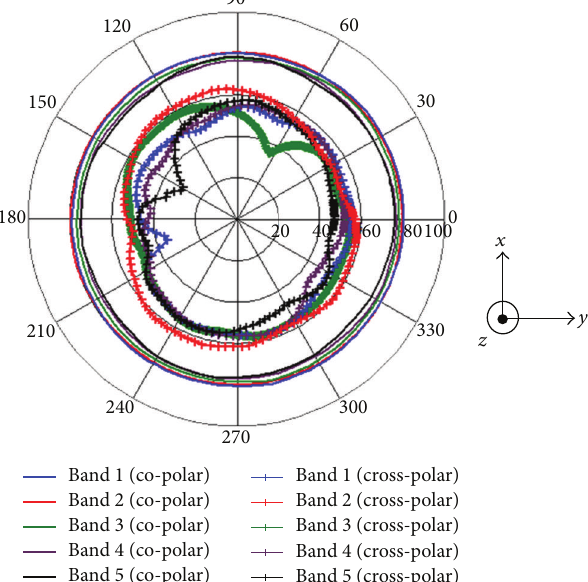
Figure 7: Measured H-plane radiation patterns (co-polar & cross- polar) at operating frequency, 𝑓 , for TMFDB25 with stubs 1, 2 at bands 1 to